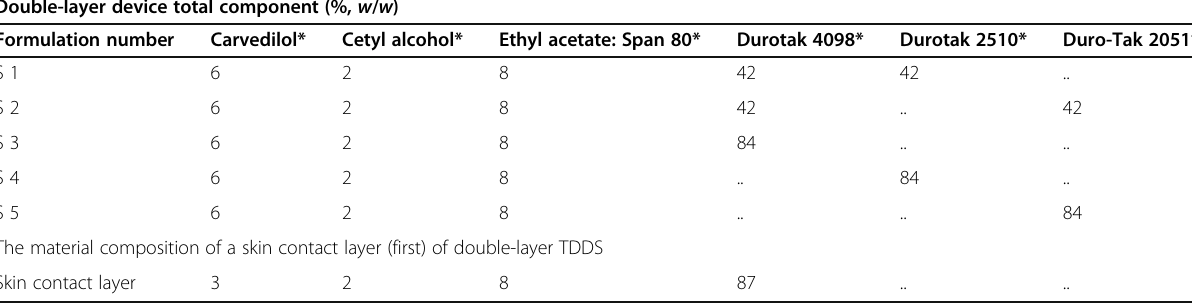
Table 1 Formulation composition of double-layer drug-in-adhesive formulation Double-layer device total component (%, w / w ) Formulation